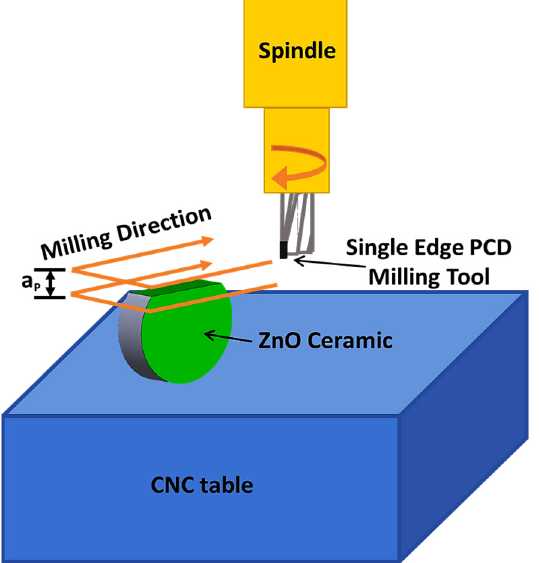
Figure 3. Schematics of milling operation on ZnO varistor.